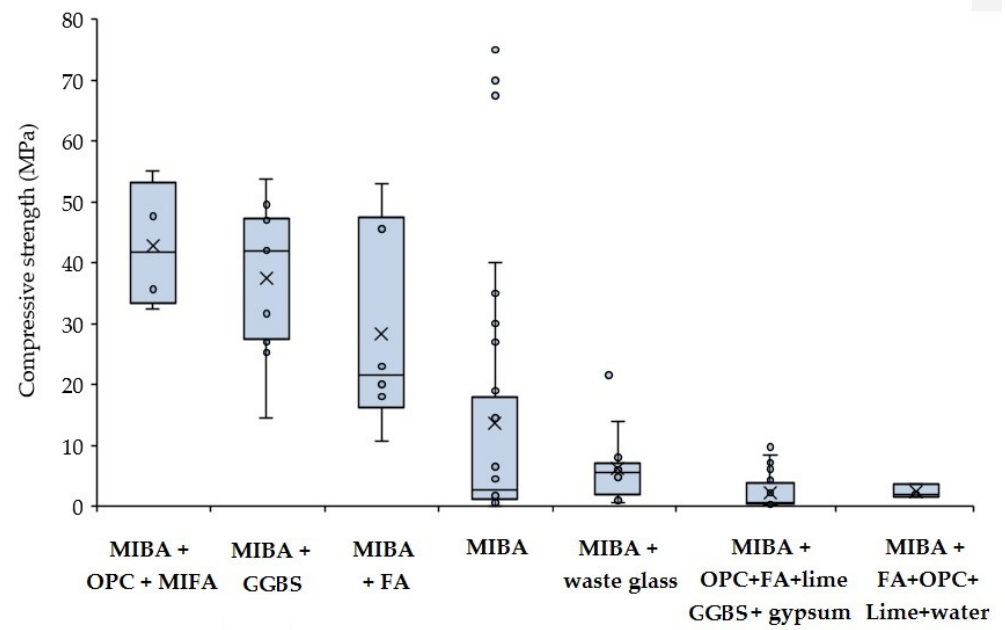
Figure 6. Effect of various types of precursor on alkali-activated materials (AAM).